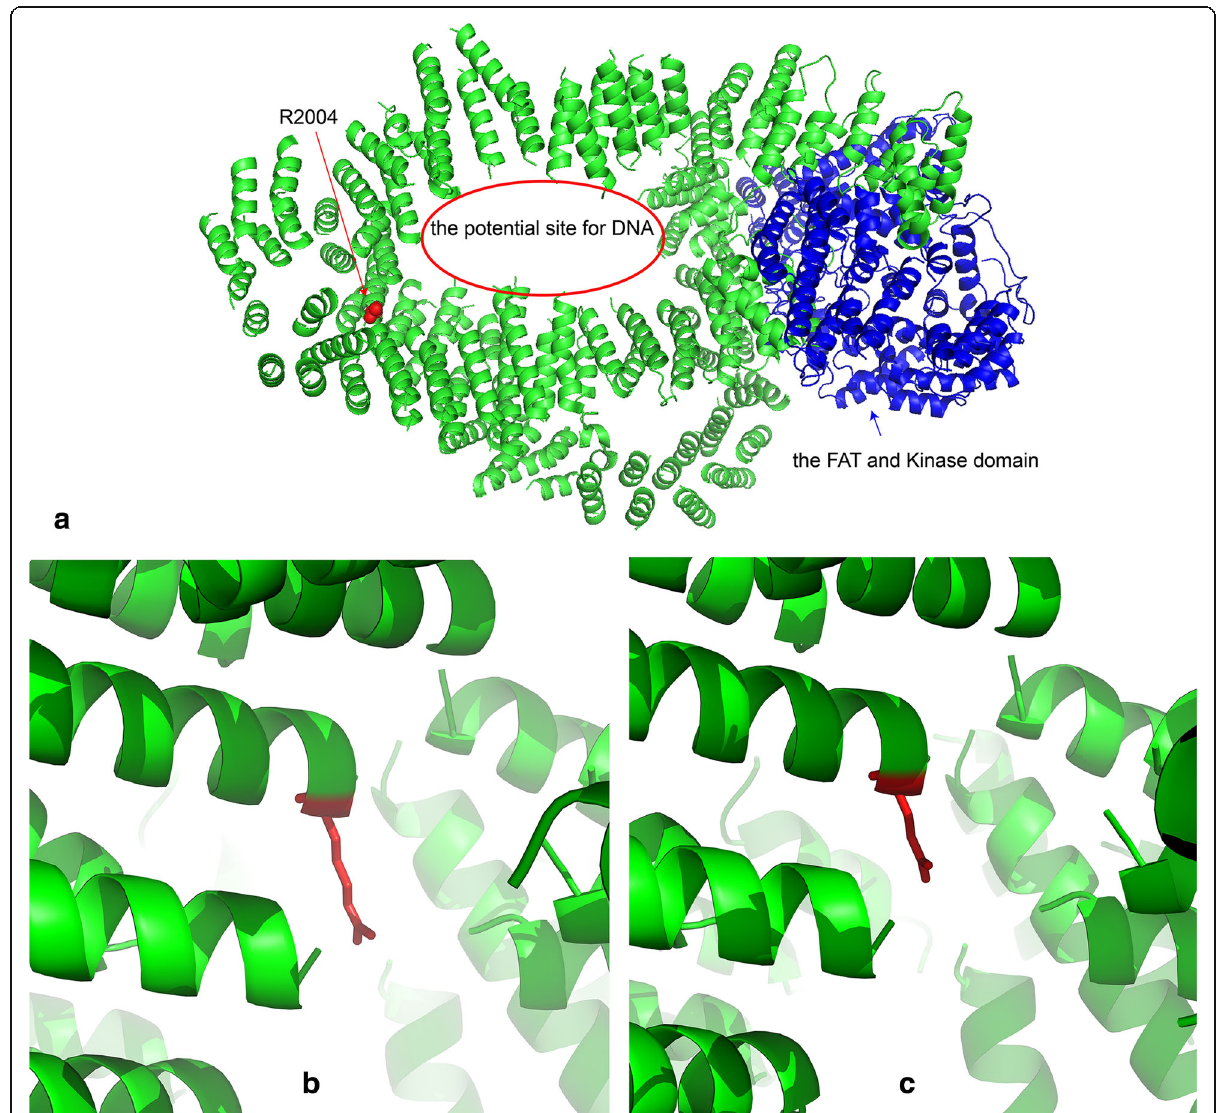
Fig. 1 Modeling of the Arg1986 residue in TRRAP. a The yeast homologue of TRRAP, Tra1(5OEJ), was chosen as a template to model TRRAP, as Tra1 is matched at position Arg2004 to Arg1986 in human TRRAP. The variant is removed from the kinase domain (noted in blue), and close to the central cavity. b Wild-type Arg1986. c Arg1986Gln. This substitution may reduce the side chain volume and decrease the binding between TRRAP and